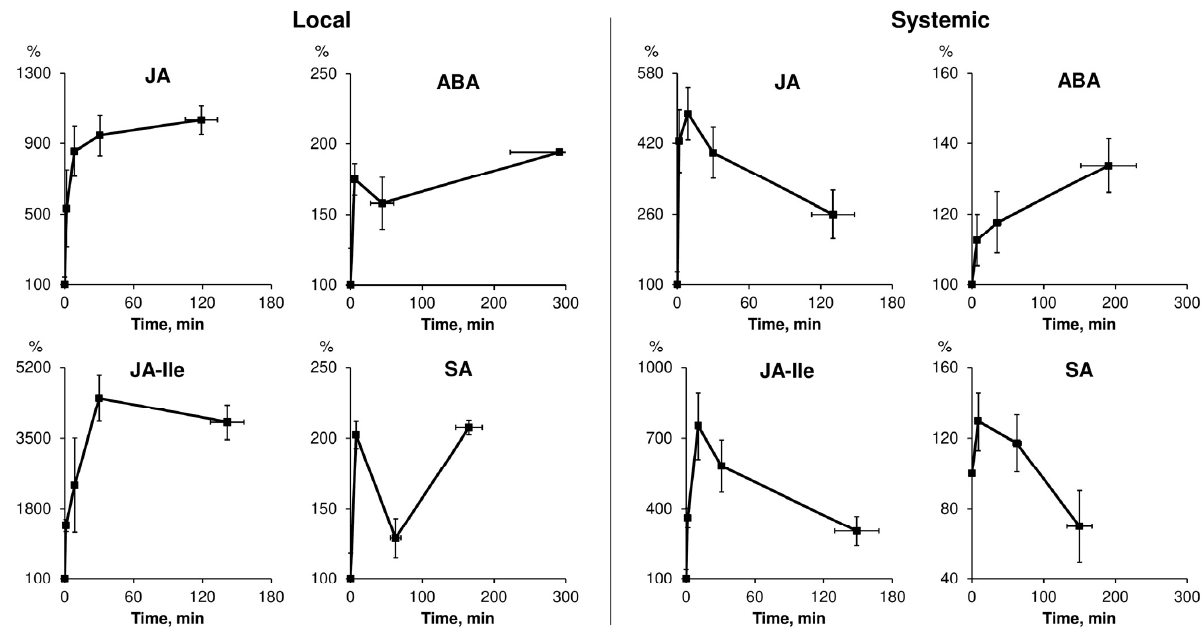
Figure 2. Dynamics of levels of jasmonic acid (JA), jasmonoyl-L-isoleucine (JA-Ile), abscisic acid (ABA) and salicylic acid (SA), induced by a local stimulus, in local and systemic plant tissues; the moment of stimulation is the 0 min time point. Hormone levels are presented as % of the resting level (0 min) and are calculated by averaging the amplitudes of changes in hormone levels. Time points are calculated by averaging time points. Values are means ± SEM of 3–20 independent studies. References for all studies included in this analysis can be found in the text of Section 2.1. Local: